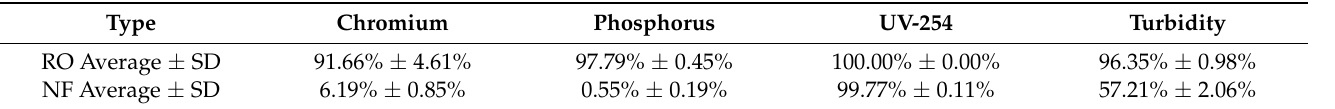
Table 6. Average ± SD at different